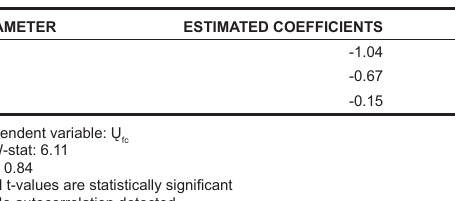
TABLE 26 Regression results for Ų